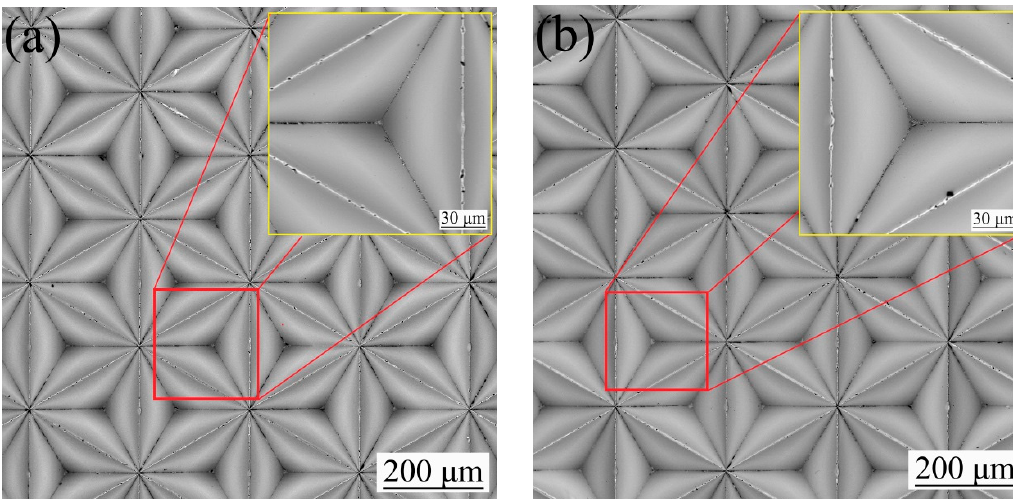
Figure 6. The micromorphology of the nickel mold: ( a ) scheme 1; ( b ) scheme 2.